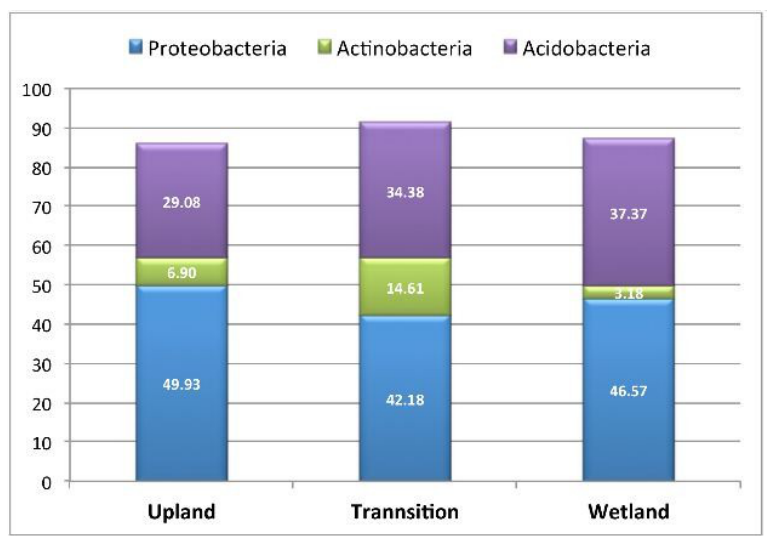
Figure 2. The relative abundance of the top three phyla.